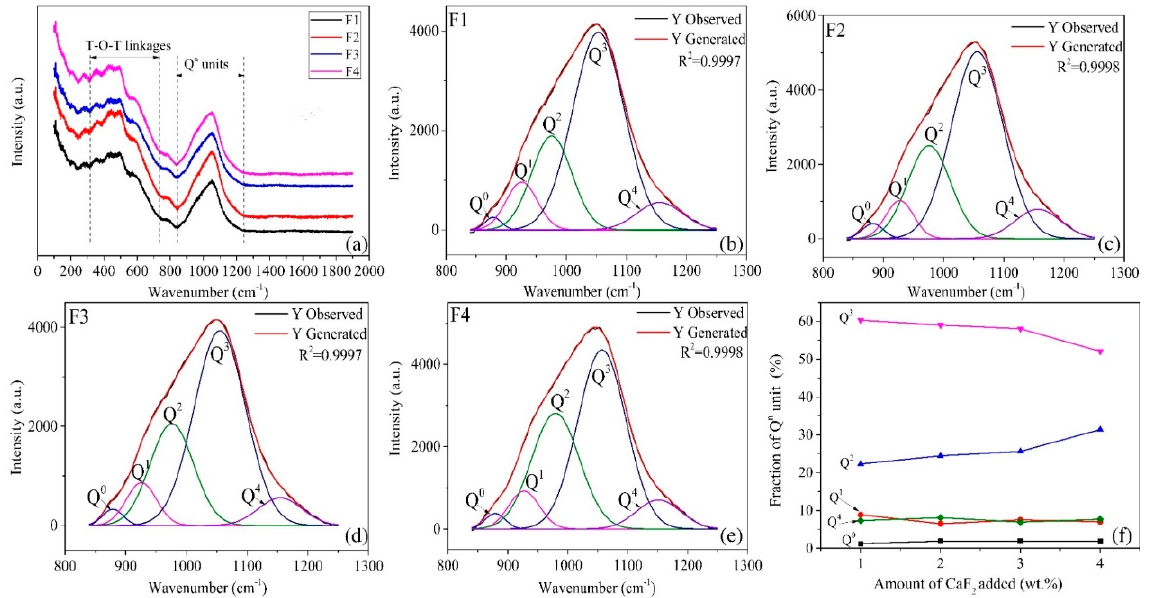
Figure 5. ( a ) Raman spectra of the quenched glass melts F1–F4, ( b – e ) deconvolution of the Raman spectra for the glass melts, ( f ) relative fraction of the Q n units for the glass melts as a function of the CaF 2 content.